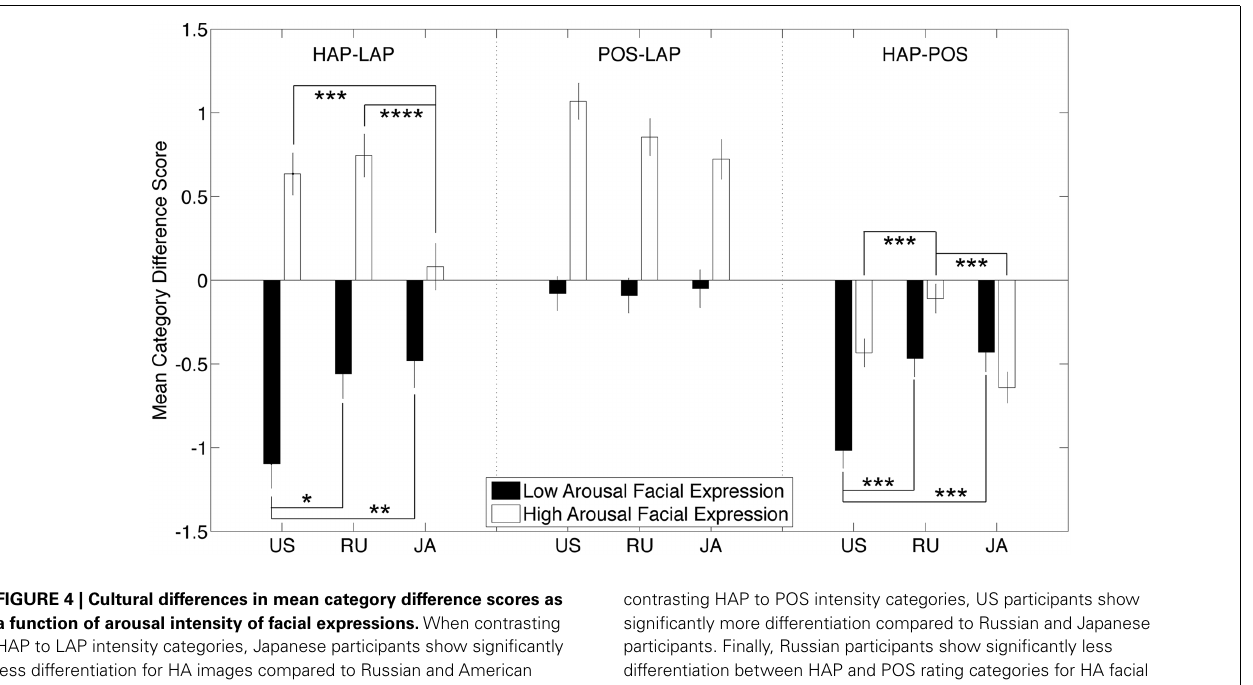
FIGURE 4 | Cultural differences in mean category difference scores as a function of arousal intensity of facial expressions. When contrasting HAP to LAP intensity categories, Japanese participants show significantly less differentiation for HA images compared to Russian and American participants. Similarly, American participants showed the greatest level of differentiation between HAP and LAP for LA facial expressions.When